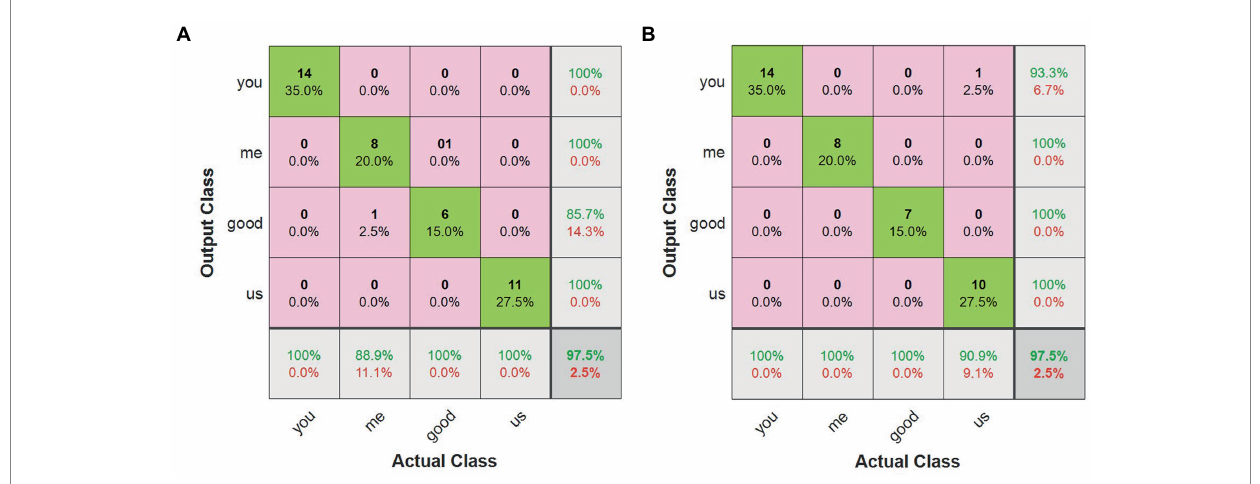
FIGURE 11 The confusion matrices of the first experiment under conditions 1 and 2. (A) The confusion matrix under condition 1. (B) The confusion matrix under condition 2. In panels (A,B) , x -axis denotes the real sample labels, and the y -axis denotes the predicted sample labels. The top and bottom elements on the main diagonal filled with green color, respectively, represent the number and percentage of the samples that are correctly predicted. The top and bottom elements inside of each pink square, respectively, represent the number and percentage of wrong predicted samples. The top and bottom elements inside of lower and right light gray squares represent the prediction accuracy and error rate of corresponding samples.